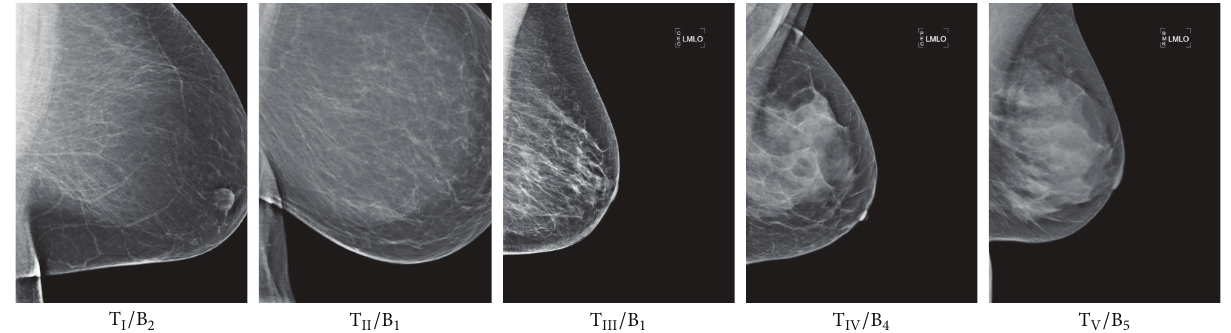
Figure 1: Example mammographic images with Tab´ar (T) risk classifications from low to high and their equivalent according to BI-RADS (B) scheme.